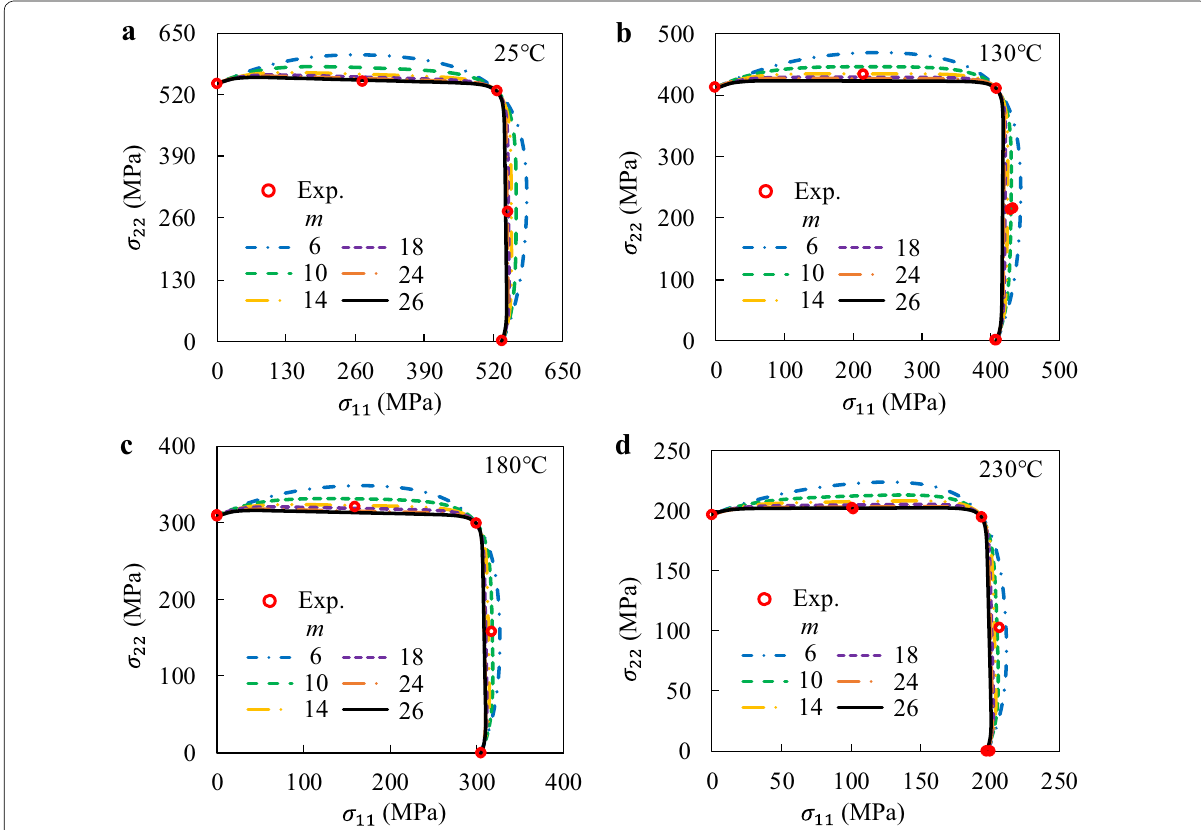
Figure 15 Initial yield loci from Yld2000-2d yield criterion with different exponent factors at ( a ) 25 °C, ( b ) 130 °C, ( c ) 180 °C and ( d ) 230 °C